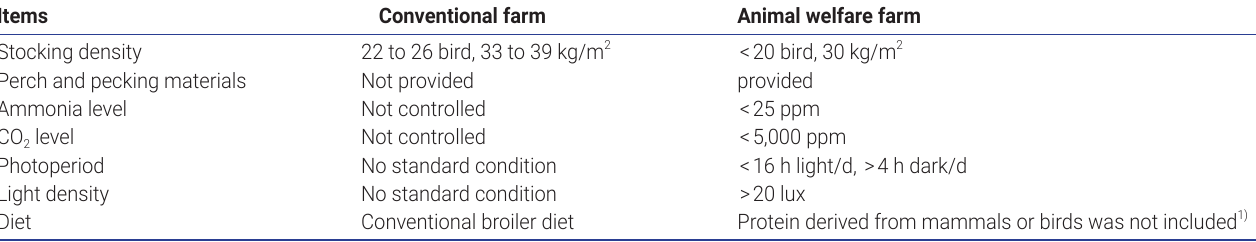
Table 1. Difference in conditions between the conventional farm and animal welfare farm Items Conventional